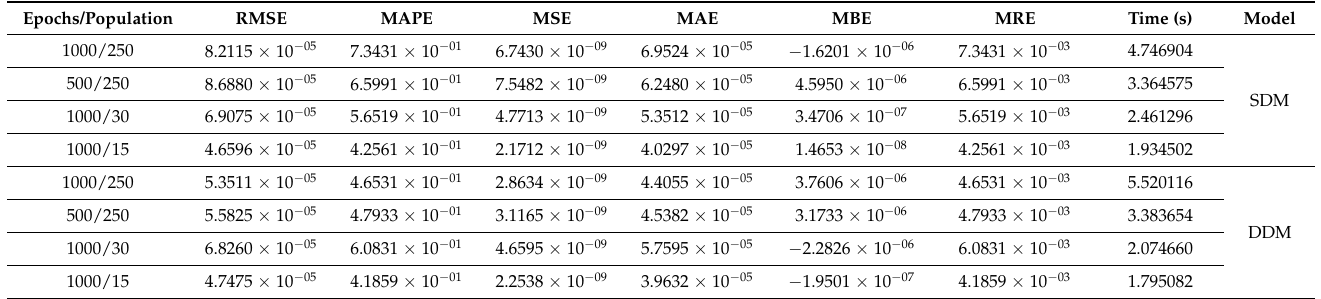
Table 23. Influence of the epochs and population on the statistical tests, amorphous silicon photo- voltaic cell.